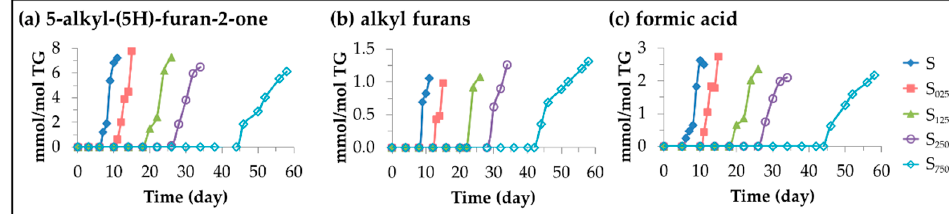
Figure 14. Evolution of the concentration, expressed in mmol/mol TG, in samples S, S 025 , S 125 , S 250 and S 750 throughout the storage at 70 °C up to a very advanced oxidation stage, of: ( a ) 5-alkyl-(5H)- furan-2-ones; ( b ) 5-alkyl-furans; ( c ) formic acid.